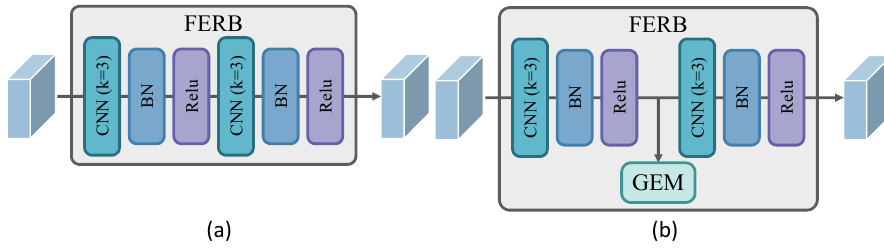
Figure 4. The pipeline of FERB. ( a ) Testing pipeline. ( b ) Training